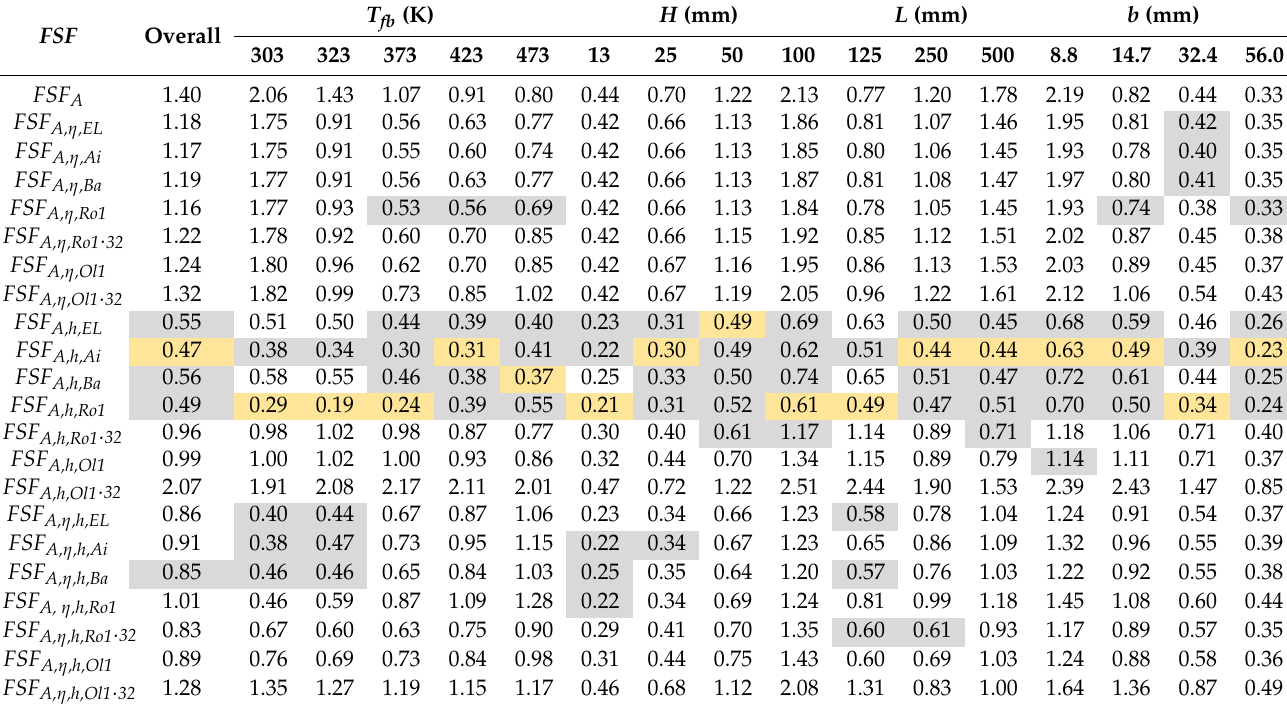
Table 5. The standard deviation of the heat flows results from the different FSF s concerning the respective reference heat flows FSF ref,i . The smallest deviations are highlighted.